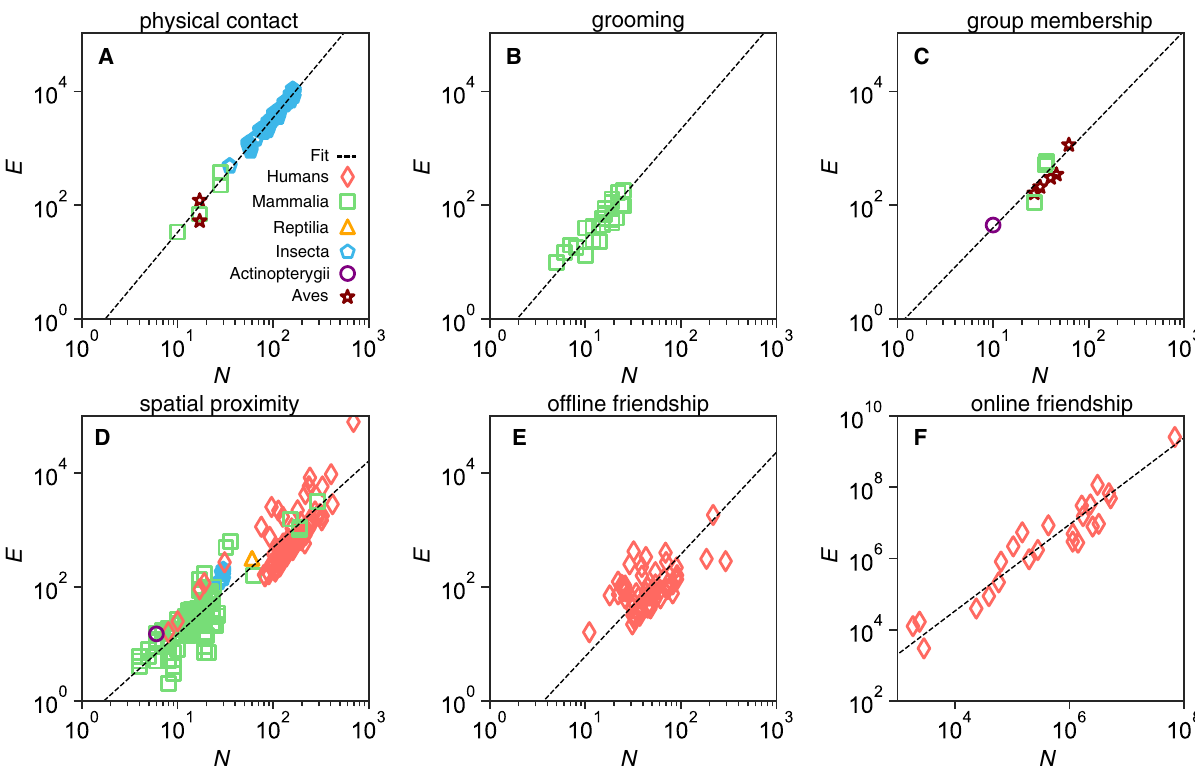
Figure 1. The number of social connections E versus the group size N across species. Empirical data (each symbol corresponds to a different species) and regression curves (dashed lines) for all 6 categories of social interactions: ( A ) physical contact ( ˆ β A = 2.01 , 95% CI [1.98, 2.04], n = 250 ); ( B ) grooming ( ˆ β B = 1.94 , 95% CI